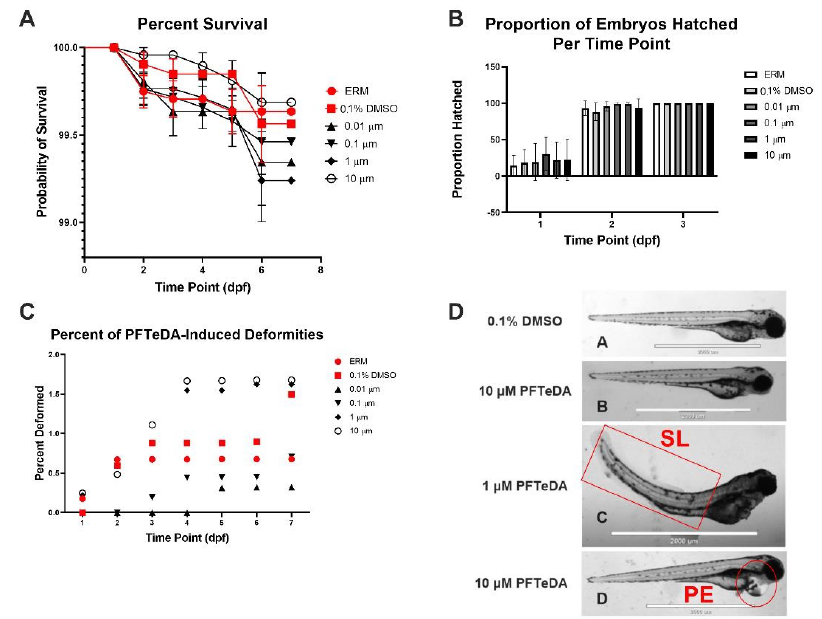
Figure 1. ( A ) Total percentage of surviving zebrafish embryos/larvae for ERM, 0.1% DMSO, 0.01 µ M, 0.1 µ M, 1 µ M, and 10 µ M PFTeDA over time based on Log-rank Mantel-Cox test. ( B ) Total percentage of hatched zebrafish embryos/larvae for ERM, 0.1% DMSO, 0.01 µ M, 0.1 µ M, 1 µ M, and 10 µ M PFTeDA over time. ( C ) Total percentage of deformities in zebrafish embryos/larvae for ERM, 0.1% DMSO, 0.01 µ M, 0.1 µ M, 1 µ M, and 10 µ M PFTeDA. ( D ) Representative zebrafish ( A , B ) and examples of spinal lordosis (SL) ( C ) and pericardium edema (PE) ( D ) at 3 dpf exposed to 0.1% DMSO, 1 µ M, and 10 µ M PFTeDA. The scale bar in each picture is 2000 µ